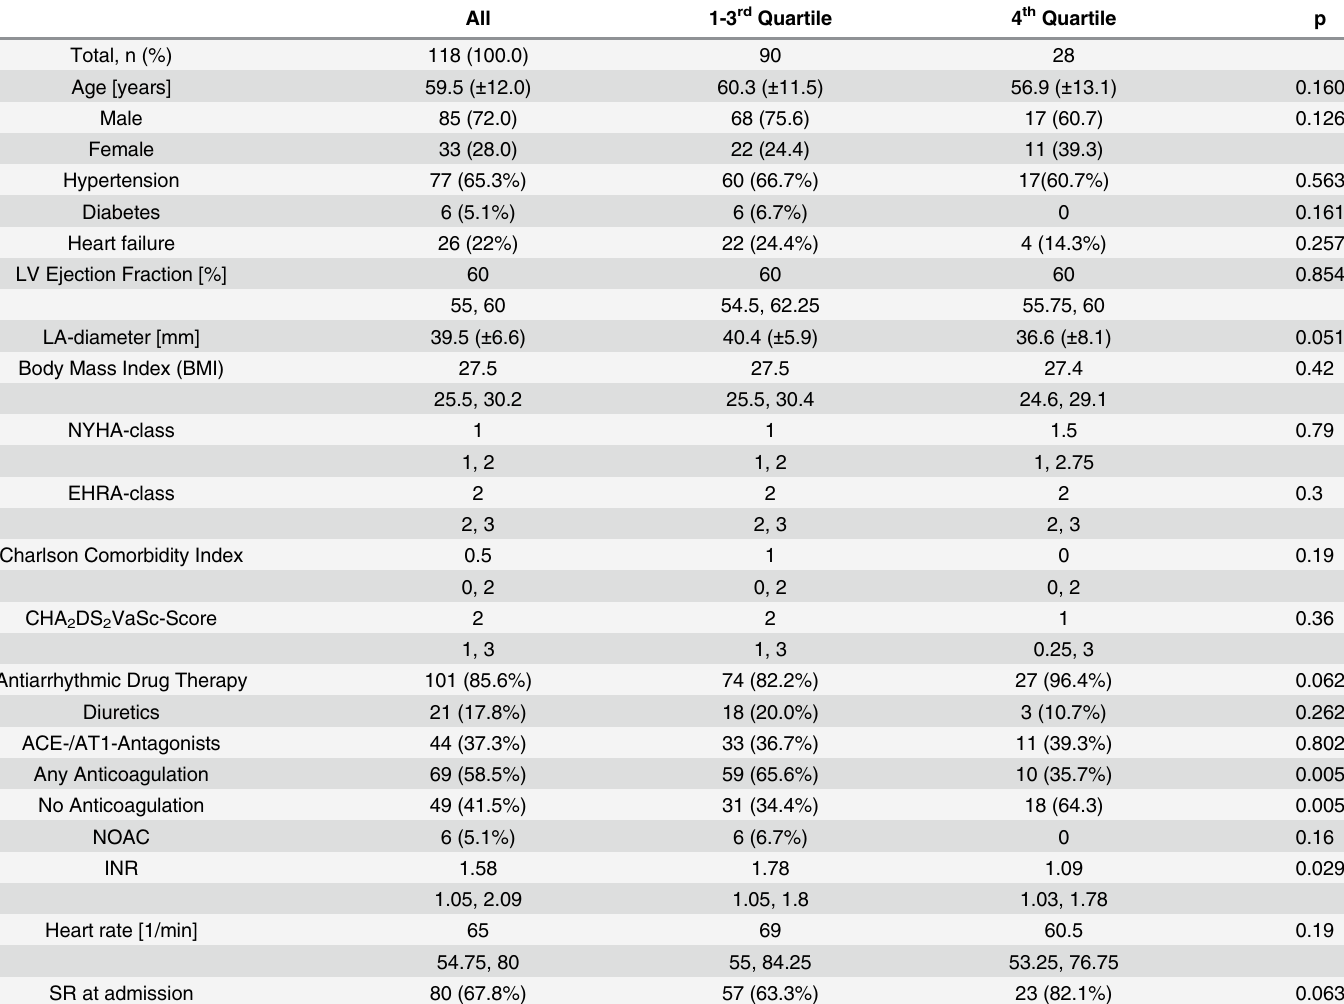
Table 1. Baseline